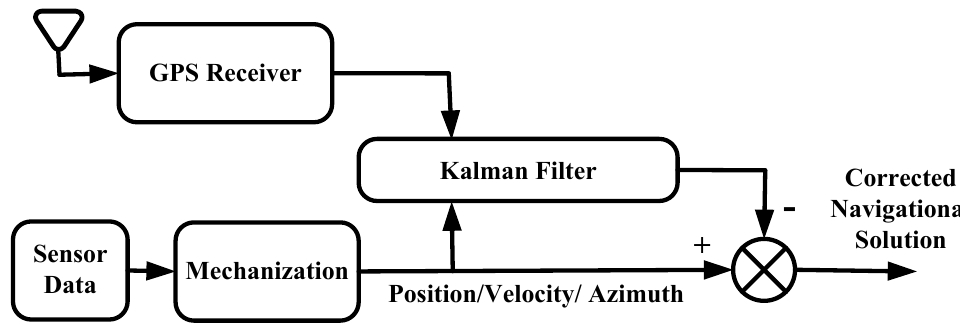
Figure 8. Schematic Diagram of the Kalman filter for RISS/GNSS Integration. The KF fuses the RISS computed position and velocity components with the corre- sponding GNSS positions and velocities when the RISS-based loosely coupled integration approach is used. This enables the computation of the positions, velocities, and altitude errors as well as sensor errors. When a GNSS outage occurs (i.e., less than four satellites are visible to the receiver with clear line-of-sight), the KF will only run the prediction stage of the filter and relies mainly on the error